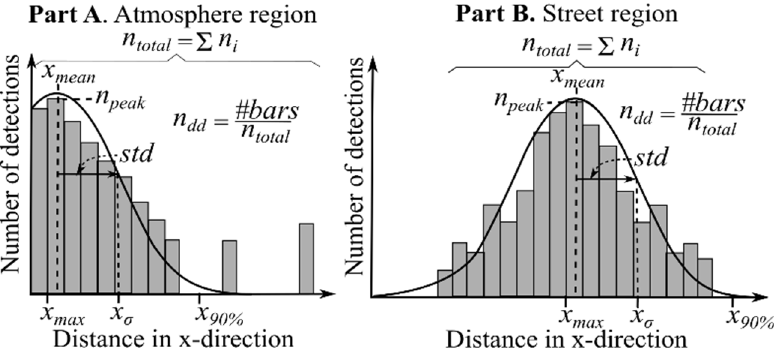
Figure 4. Parameters used to characterize the distributions in the atmosphere and street region.